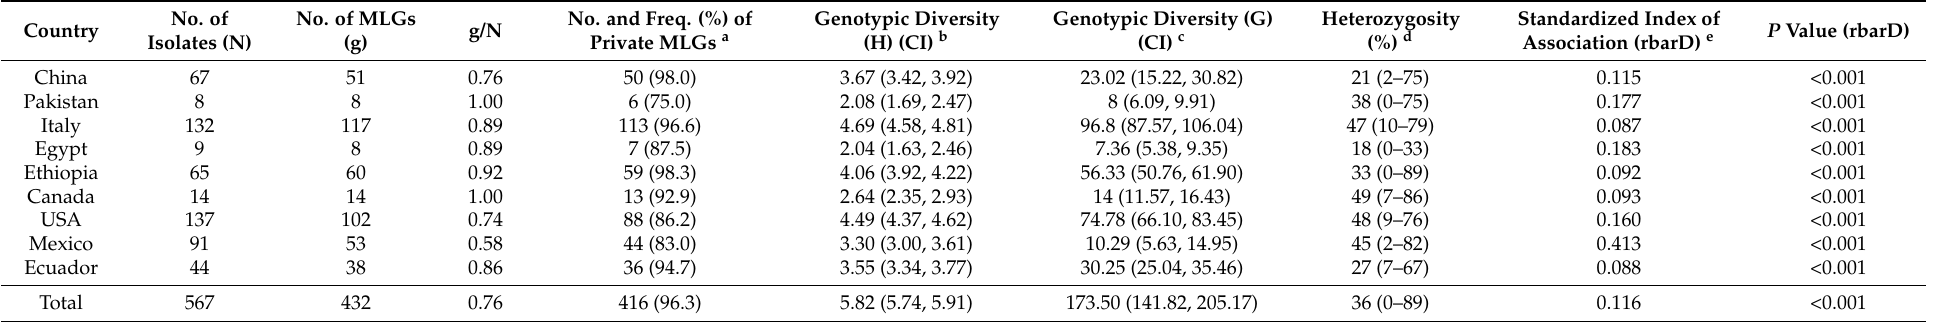
Table 3. Numbers of Puccinia striiformis f. sp. tritici isolates, numbers of multi-locus genotypes (MLGs), g/N values, heterozygosity, Stoddart and Taylor’s MLG diversity (G) and confidence interval (CI), and Shannon–Wiener index of MLG diversity (H) over 14 SSR loci, as well as standardized index of association (rbarD) and its probability ( P ) for indication of reproduction mode in the collections from nine